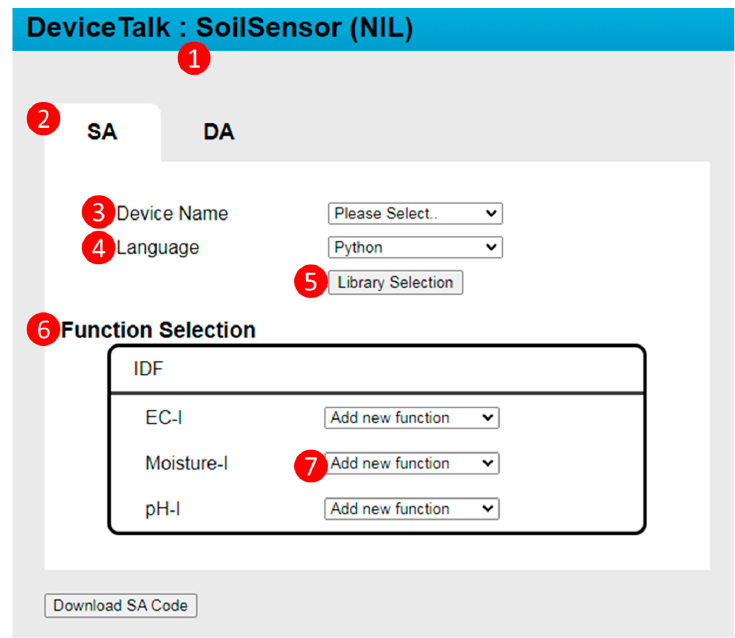
Figure 4. The structure of the DeviceTalk GUI. ( a ) The main GUI structure; ( b ) The structure of the Library Selection popup window; ( c ) The structure of the Function Manager popup window.